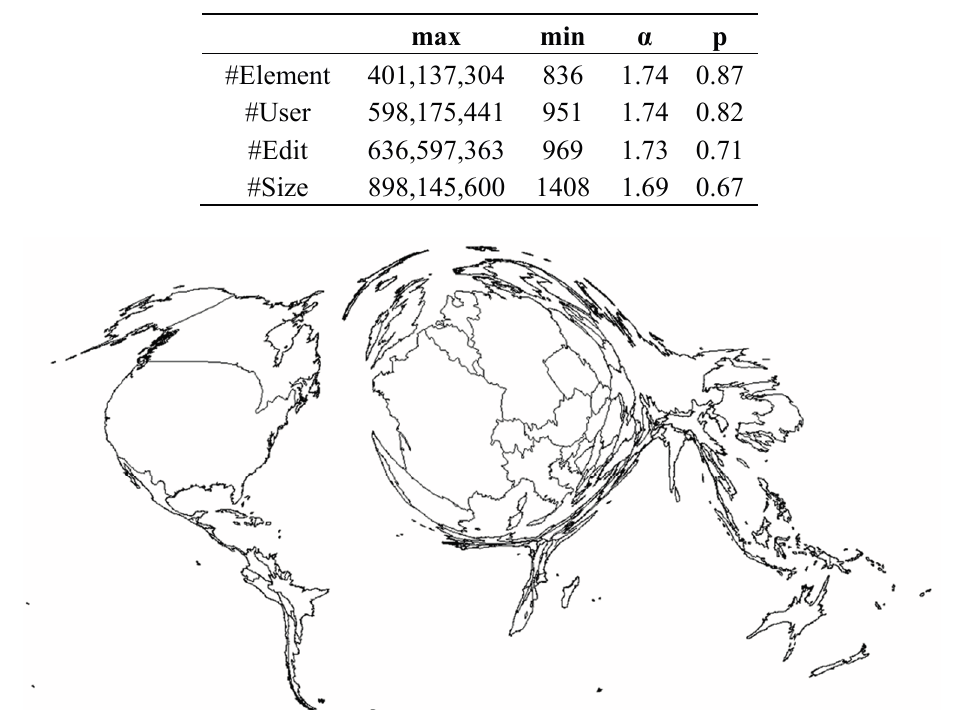
Figure 4. The cartogram showing the spatial distribution of global OSM elements at country